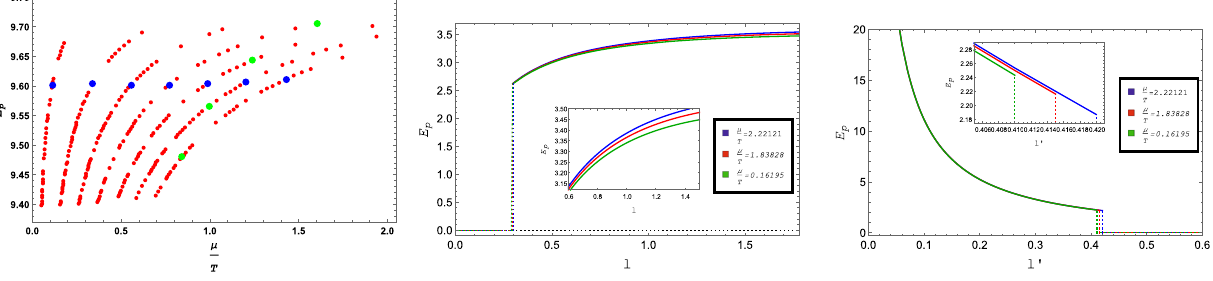
for l (cid:3) = 0 . 1 , l = 0 . 5 in 2 + to l (cid:3) for l = 0 . 8 in 2 + 1-dimensional field theory. The three different T values of μ are chosen to have the same T equal to 0 . 21 and different T